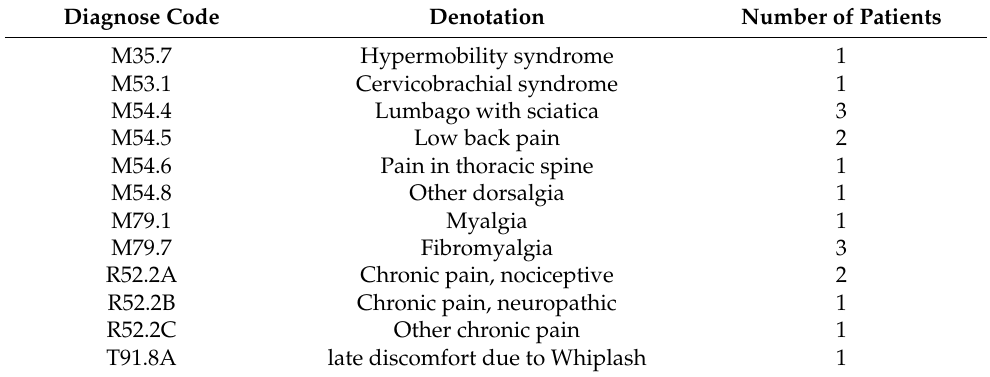
Table 1. Main diagnosis code (ICD-10-SE) of the 18 patients.